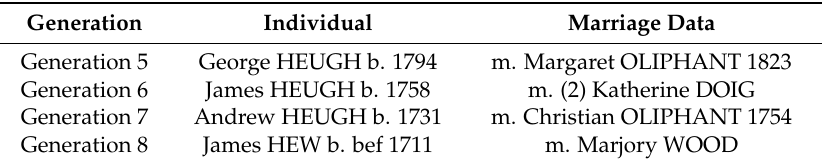
Table 5. Generations 5 to 8.